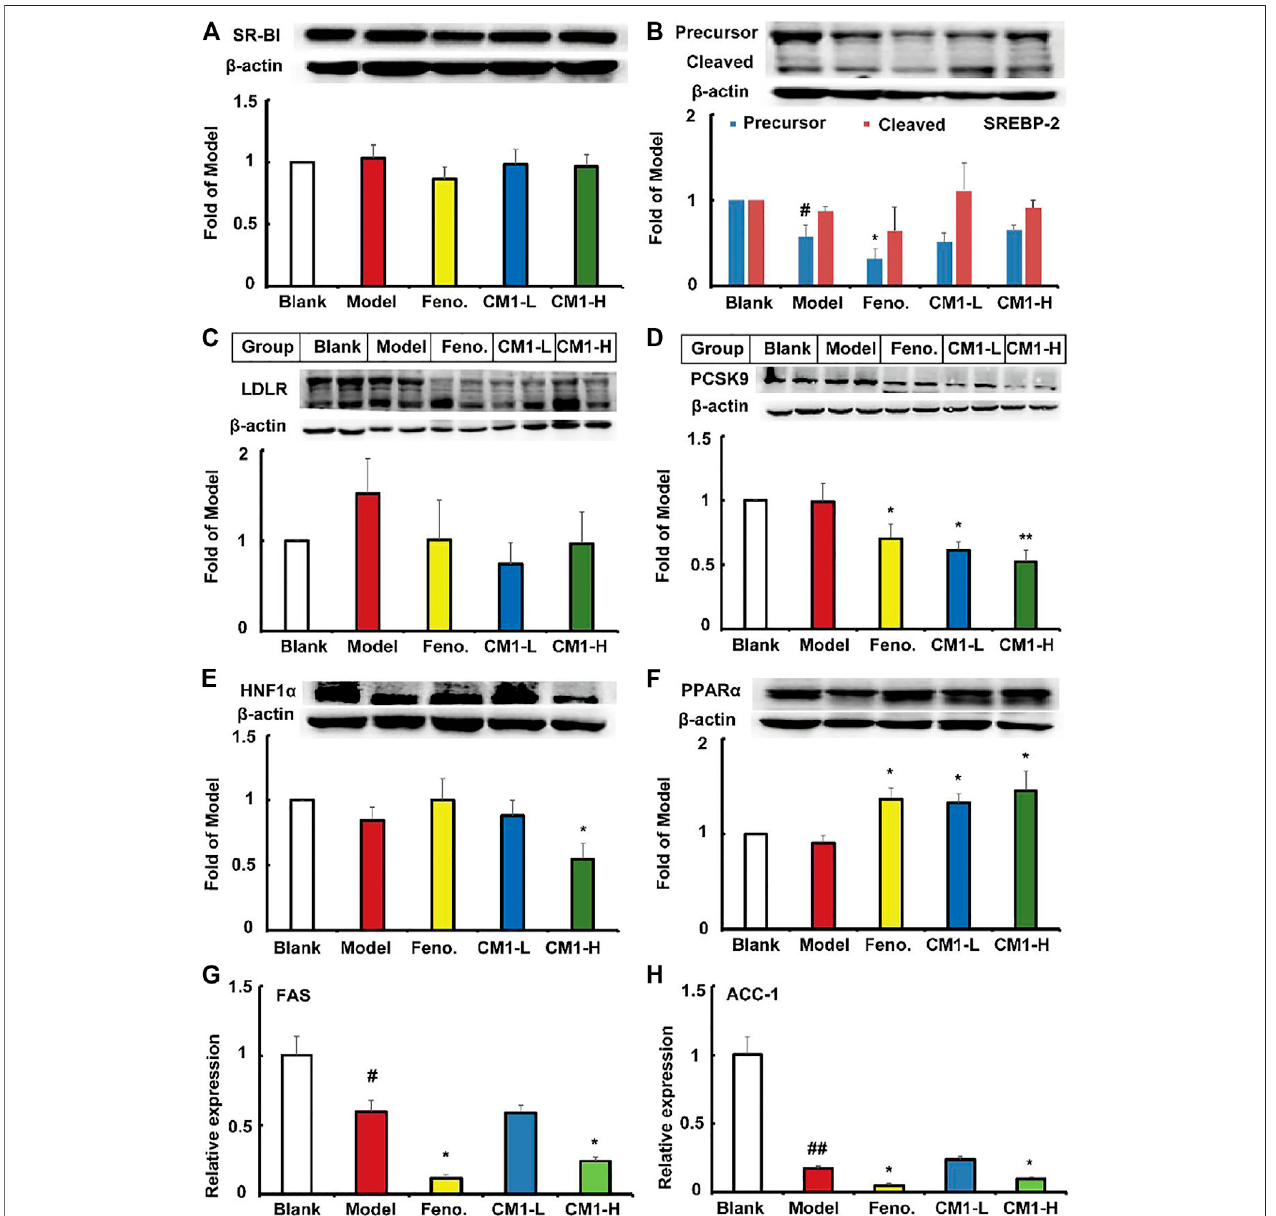
FIGURE9| EffectofCM1onthelipidmetabolismrelatedproteinsintheliveroftheC57BL/6Jmice( n ≥ 3).Proteinexpressionanddensitometricquanti fi cation. (A) , SR-BI; (B) , SREBP-2; (C) , LDLR; (D) , PCSK9; (E) , HNF1 α ; (F) , PPAR α ; (G) , mRNA expression of FAS; (H) , mRNA expression of ACC-1. # means p < 0.05 vs . Blank; ## means p < 0.01 vs . Blank; *means p < 0.05 vs . Model, and **means p < 0.01 vs . Model.